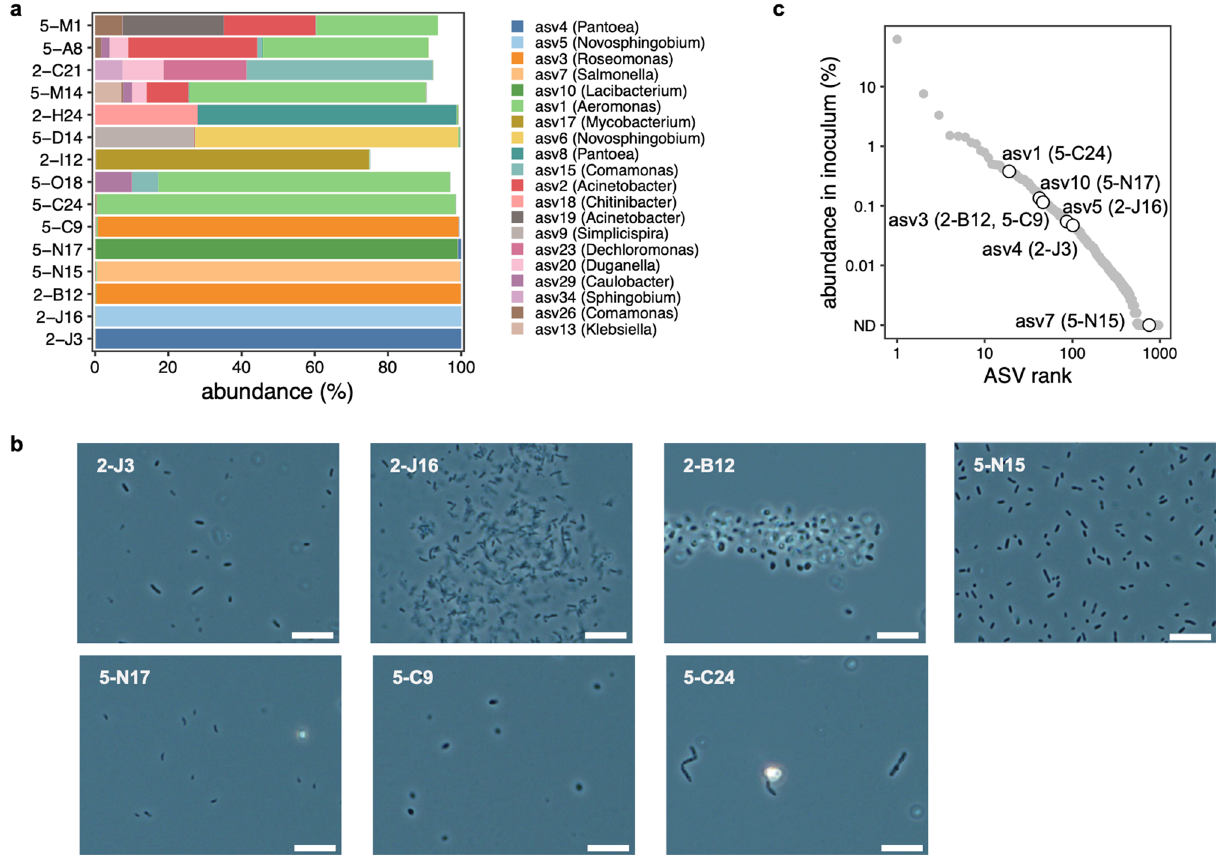
Figure 4. Screening and identification of scaled-up cultures. ( a ) Bar charts showing the composition of the generated cultures, as evaluated by 16S rRNA gene amplicon sequencing. The top-20 most abundant ASVs, based on maximum abundance across cultures, are shown and cultures are sorted along with the y-axis based on the abundance of the most dominant ASV. Fill colors represent ASVs, with corresponding genus-level taxonomic assignments shown in the legend. Culture identifiers shown on the y -axis reflect the incubation period and well number of the scaled-up culture multiwell plate, separated by a hyphen (for example, culture 2-J3 was obtained after two days of cultivation in droplets and cultured in well J3). ( b ) Phase contrast images of cells in scaled-up cultures containing a single dominant ASV with an abundance of at least 98%. The scale bar for all photographs is 10 µm. ( c ) Rank abundance curve of ASVs in the source sample (that is, water from an artificial pond). Circles represent ASVs recovered in scaled-up cultures containing a single dominant ASV with an abundance of at least 98%, with corresponding culture identifiers indicated between brackets. ND: not